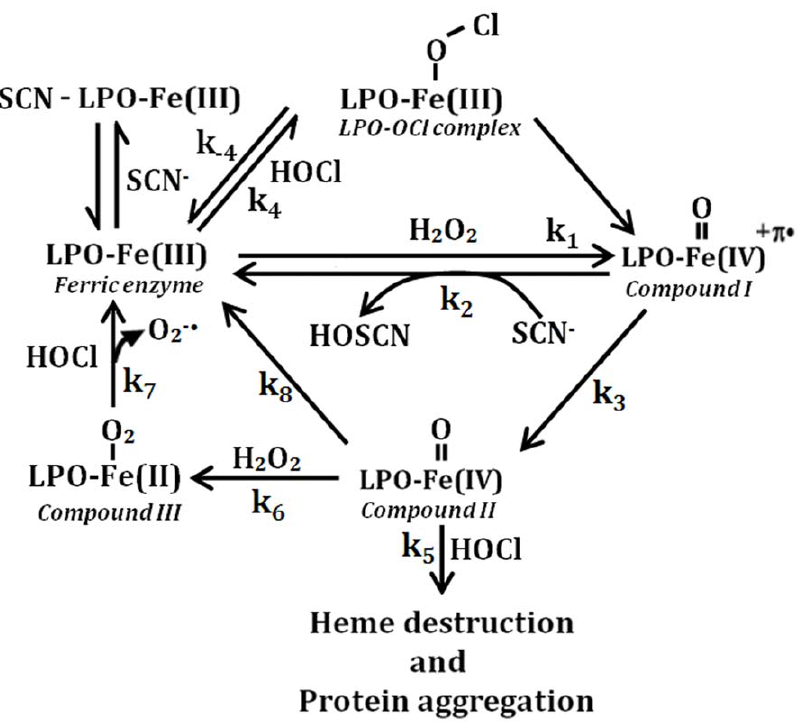
Figure 9. A general kinetic scheme showing the influence of HOCl on the LPO catalytic cycle.